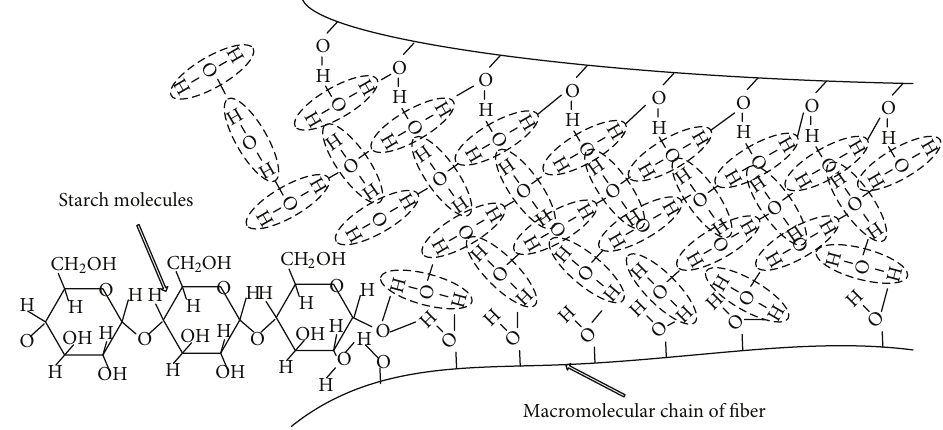
Figure 5: Schematic of water’s bridge-connection.